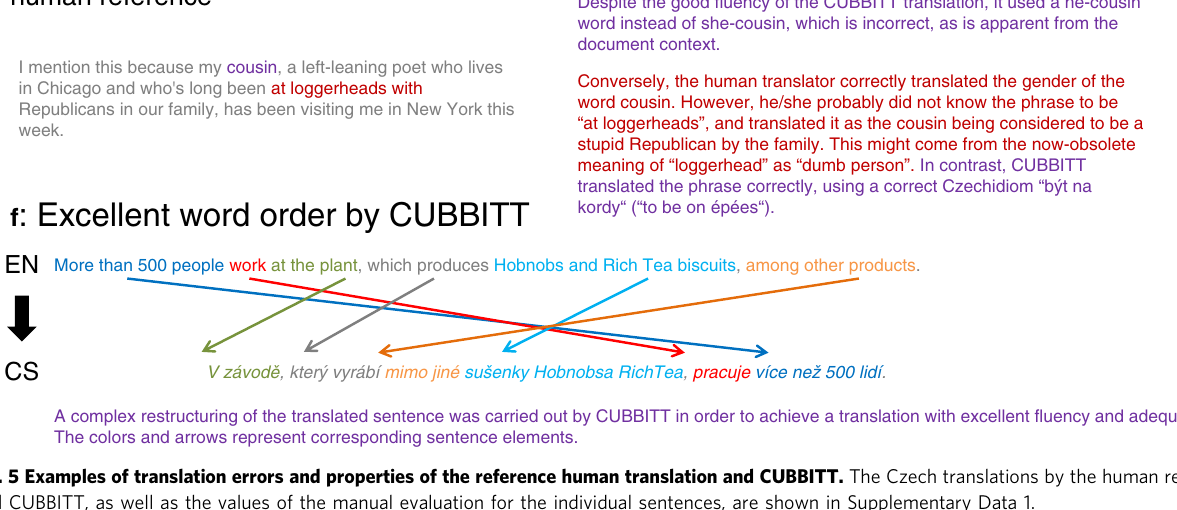
Fig. 5 Examples of translation errors and properties of the reference human translation and CUBBITT. The Czech translations by the human reference and CUBBITT, as well as the values of the manual evaluation for the individual sentences, are shown in Supplementary Data